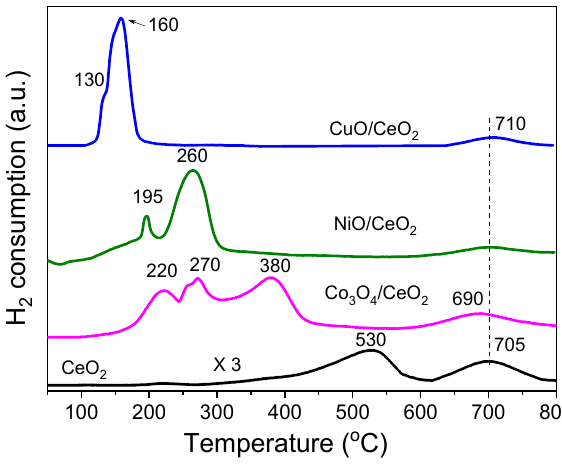
Figure 4. The H 2 ‐ temperature ‐ programmed reduction (TPR) profiles of MO x /CeO 2 samples. Figure 4. The H 2 -temperature-programmed reduction (TPR) profiles of MO x /CeO 2